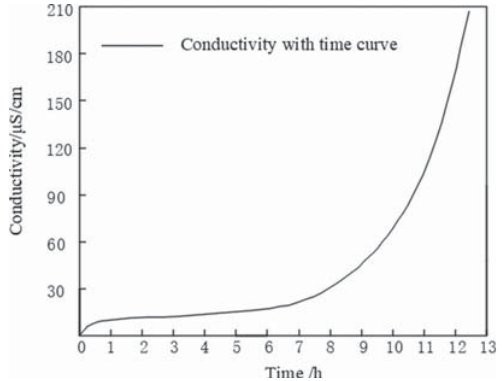
Figure 2: The curve of conductivity and time.